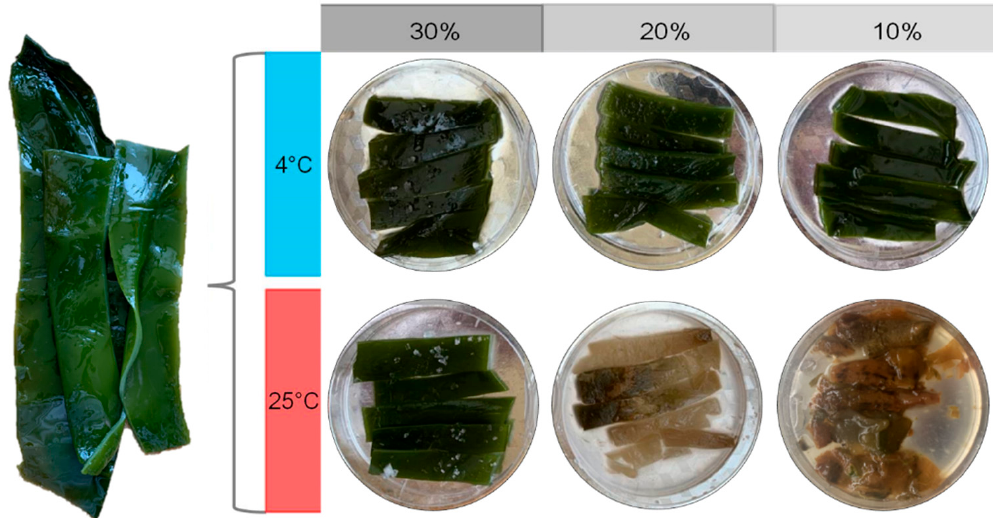
Figure 1. States of fresh salted kelp and salted kelp with different salt concentrations at 4 °C and 25 °C after 30 days of preservation.